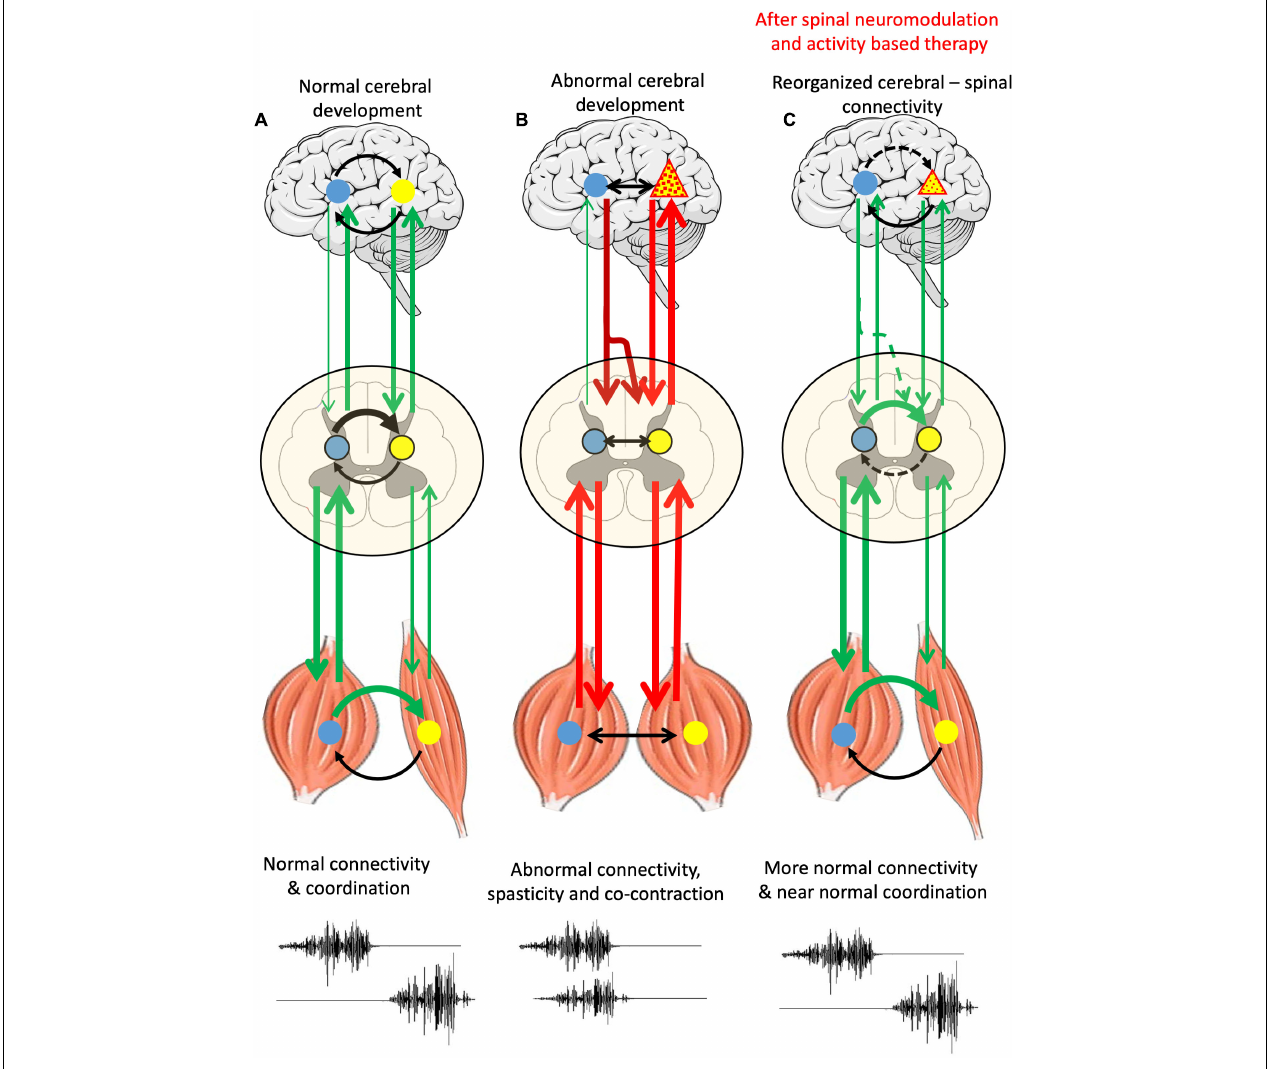
FIGURE 1 | Schematic representation of supraspinal-spinal-muscle connectivity in normal cerebral development, abnormal cerebral development and in abnormal cerebral development after spinal neuromodulation and activity-based therapy (A) normal brain-spinal networks and muscles with sensors, bidirectionally communicating input and output signals forming a complete loop, including reciprocal EMG of agonist and antagonist muscles, see two channels at the bottom. (B) A region of supraspinal pathology (triangle) resulting in aberrant descending signals causing disruptive degrees of co-contractions of flexor and extensor motor pools and muscles. (C) A remodeling process can of supraspinal and spinal networks can begin with a combination of a non-invasive electrical neuromodulation technique that empowers the spinal networks to begin to assume a dominating control of normalizing the coordination of flexor and extensor motor pools. With repetitive practice in the presence of neuromodulation, we propose that there will be significant reorganization toward a gradually occurring normalization of supraspinal and spinal